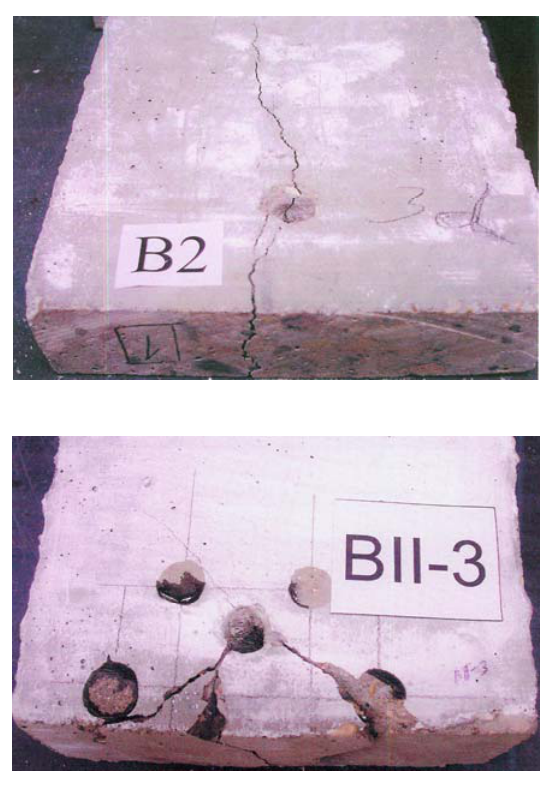
Fig 6. Propagation of a longitudinal crack in the speci- mens BII-3 and B2 in which the distance of δ was equal respectively to 21,8 mm and 40 mm